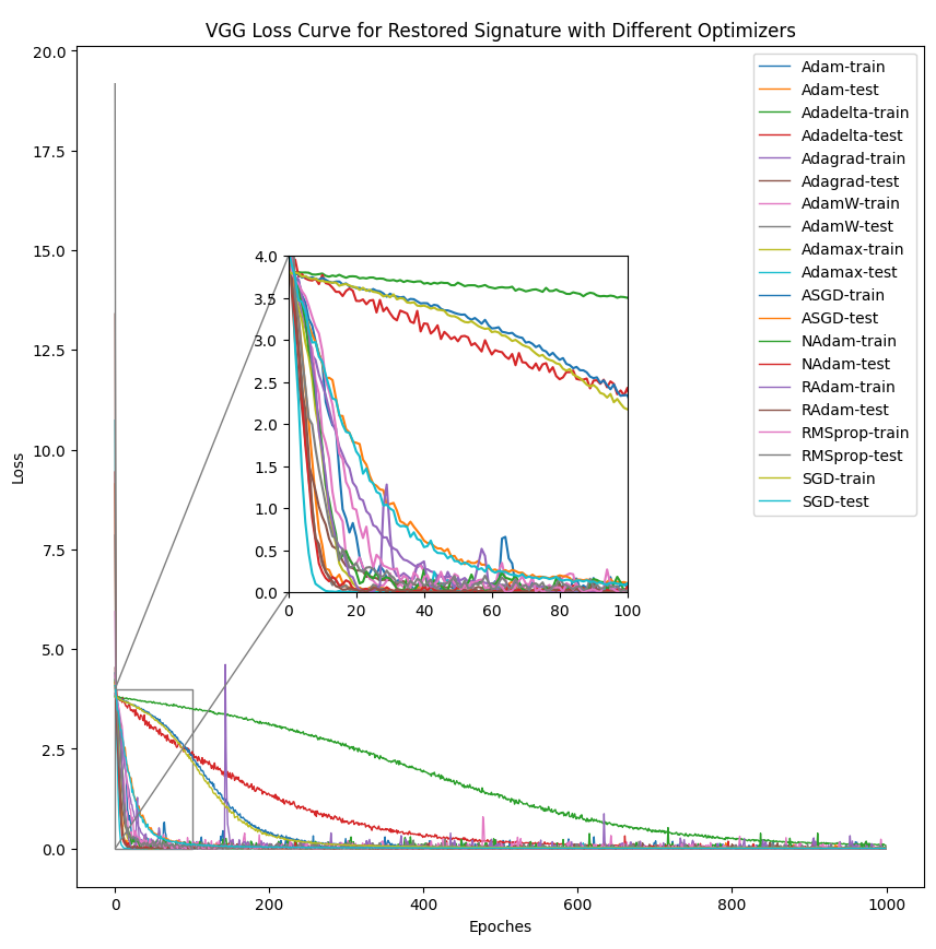
Figure 13. The loss curve of VGG with respect to 10 different optimizers. Both the learning loss and testing loss for each optimizer are covered in the graph. The zoom-in area is ( x 1 , x 2 ) = (0, 100), ( y 1 , y 2 ) = (0,